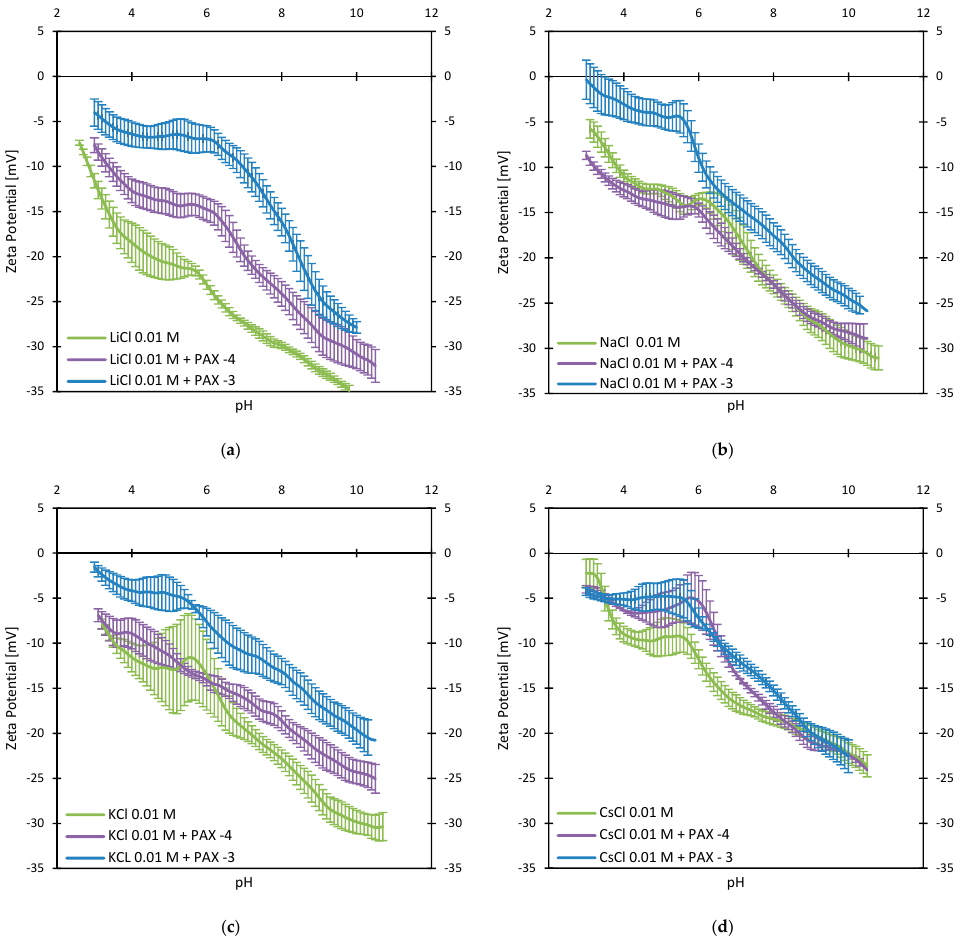
Figure 6. Zeta potential of pyrite as function of pH for different chloride salts and different concentrations of amyl xanthate (PAX). ( a ) LiCl, ( b ) NaCl, ( c ) KCl, and ( d ) CsCl. Concentrations of PAX are 0 M, 10 − 4 M ( − 4), and 10 − 3 M ( − 3).